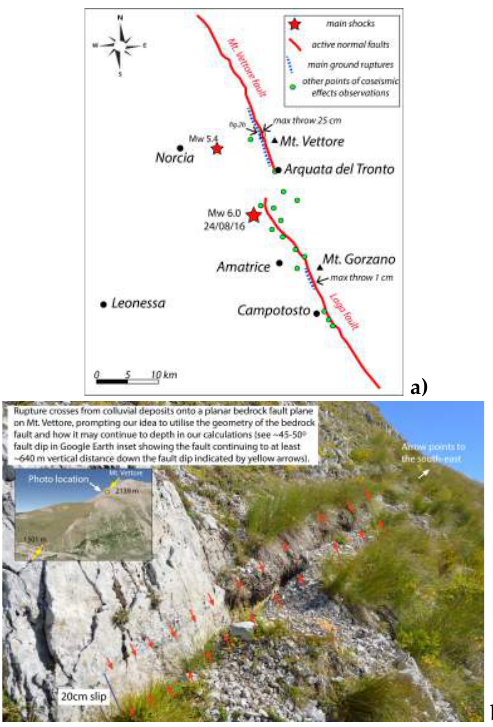
Figure 2: surface effects after the 24 Aug earthquake: a) location map of ruptures by EMERGEO WG [2016], Piccardi et al. [2016], Pace et al. [2016]; b) rupture detail at Mt.